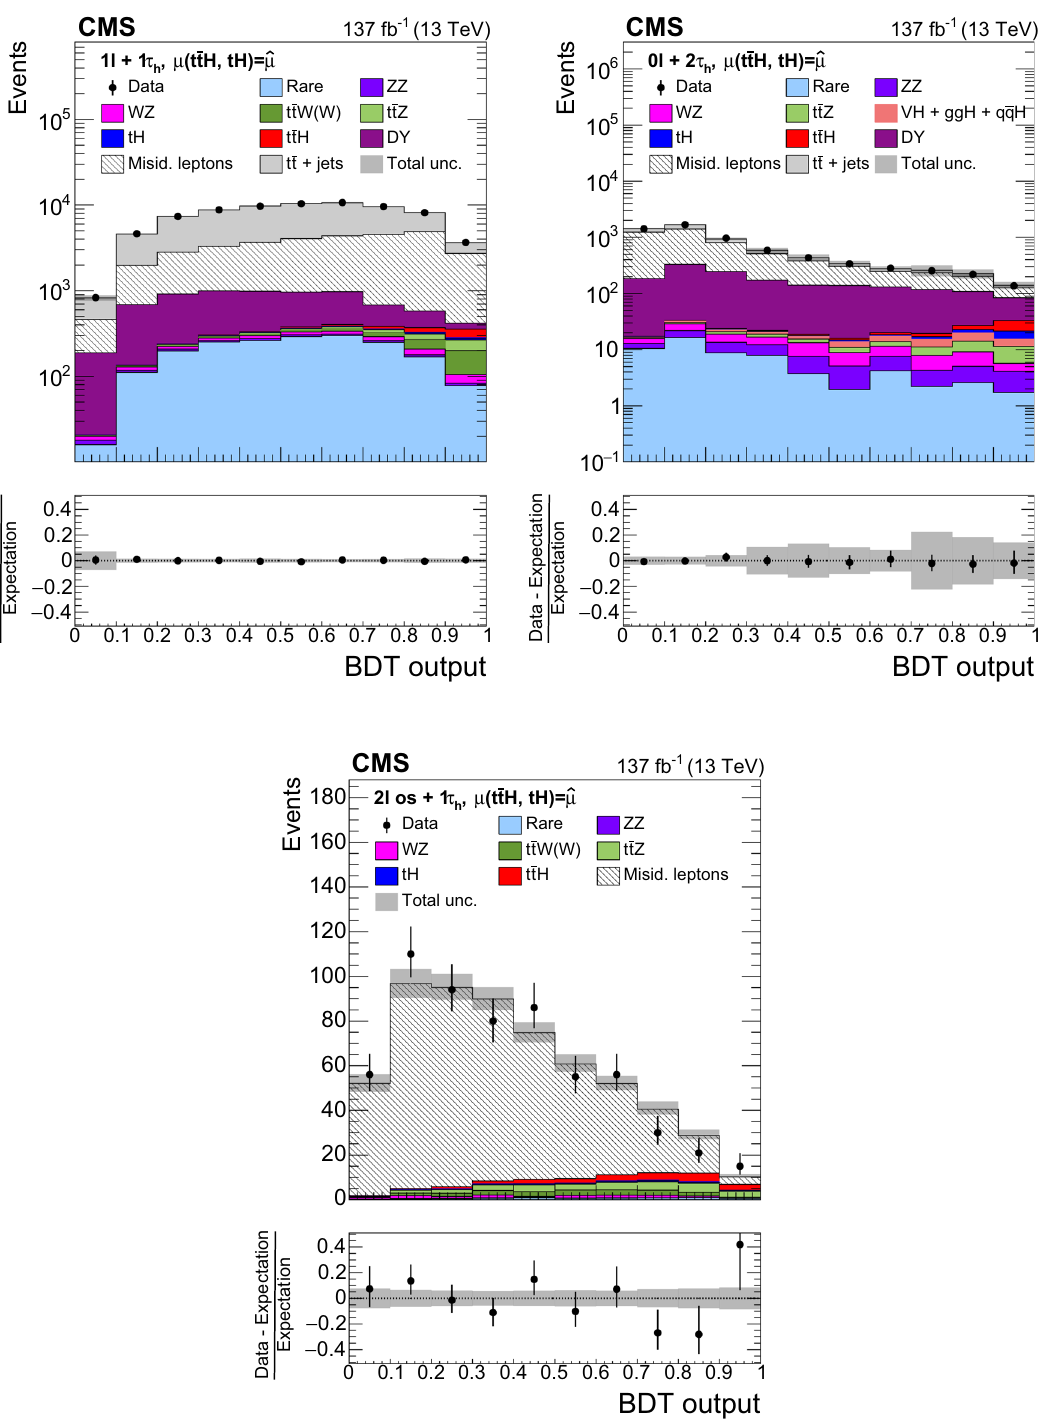
Fig. 10 Distributions of the BDT output for events selected in the 1 (cid:4) + 1 τ h (upper left), 0 (cid:4) + 2 τ h (upper right), and 2 (cid:4) OS + 1 τ h (lower) channels. The distributions expected for the ttH and tH signals and for background processes are shown for the values of the parameters of